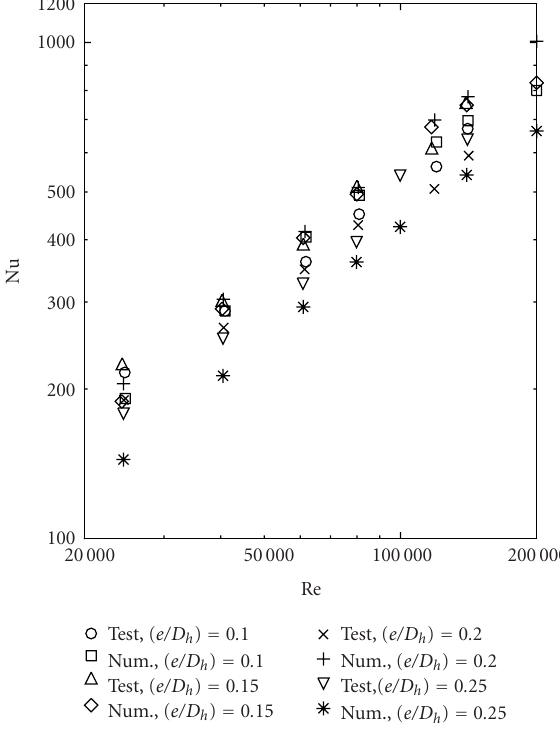
Figure 4: Comparison between the numerical and test results ( P/e =